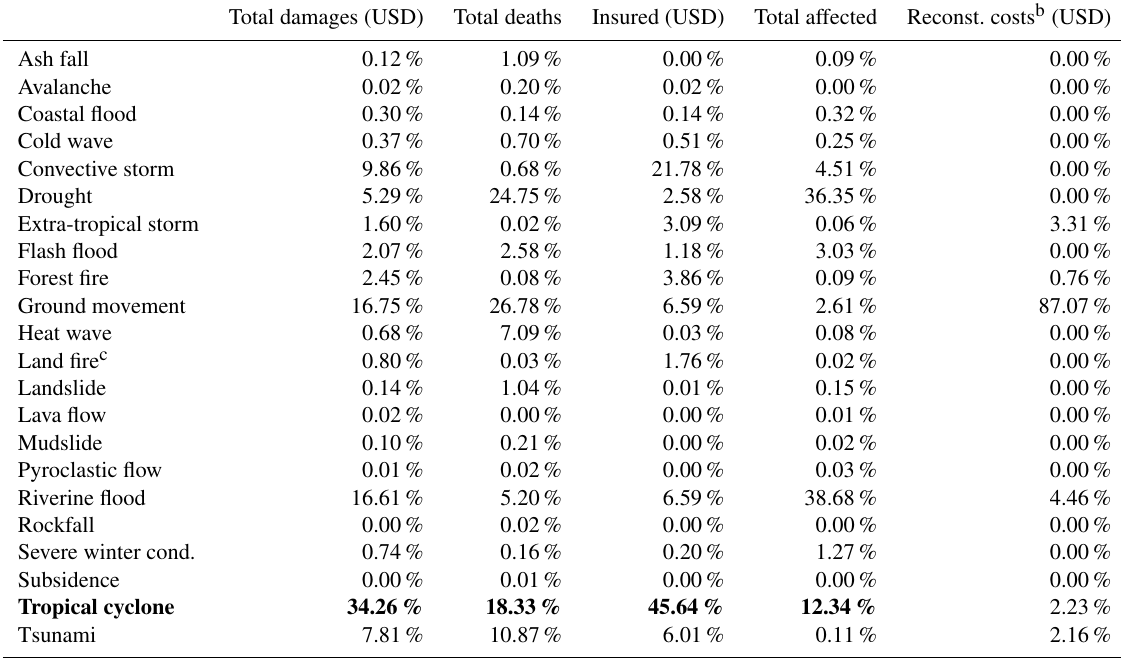
Table A1. EM-DAT reporting proportions a . Tropical cyclone-related statistics were emphasized.